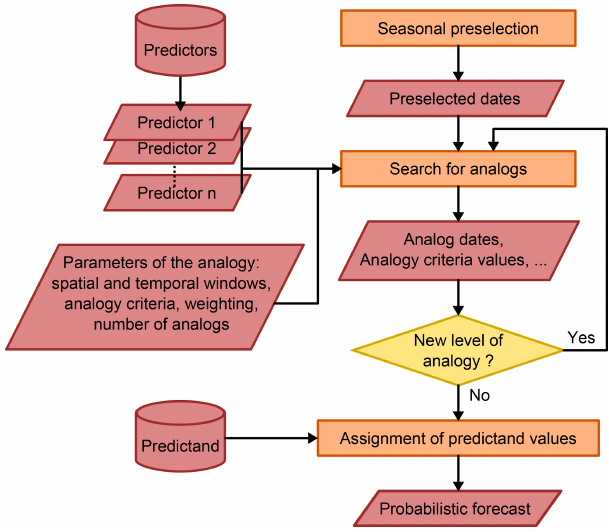
Figure 3. Simplified flowchart of the AM implementation in At-